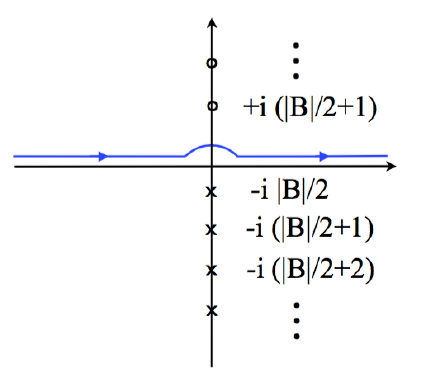
Figure 1: Location of the poles (negative imaginary axis) and of the zeroes (positive imaginary axis) of the one-loop determinant. The contour of integration is deformed in the upper-half plane to avoid the pole at σ = 0 present in the B = 0